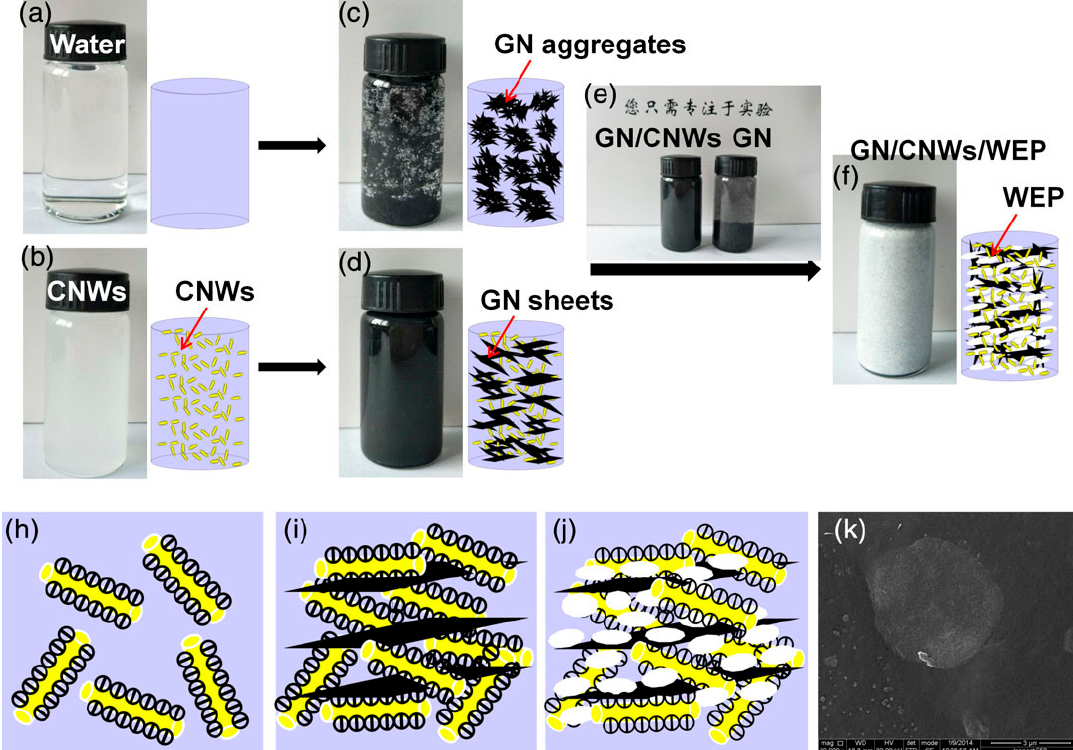
Figure 6. Neat water ( a ); aqueous dispersion of CNC (CNWs) ( b ); dispersion of GN in water ( c ); GN in CNWs aqueous dispersions ( d ); dispersion stability of GN in water and CNWs aqueous dispersions after the settlement of 30 min ( e ); dispersion of 1.0% GN/CNWs in waterborne epoxy polymeric matrix (WEP), ( f ); schematic of CNWs with negative charges ( h ); schematic of negatively charged CNWs adsorbed on graphene sheets ( i ); schematic of GN sheets stabilized in WEP assisted with CNWs ( j ); Field emission scanning electron microscopy (FE-SEM) micrograph of CNWs adsorbed on graphene sheet ( k ). Reproduced with permission from Reference [148]. Copyright ©2019, Wiley.